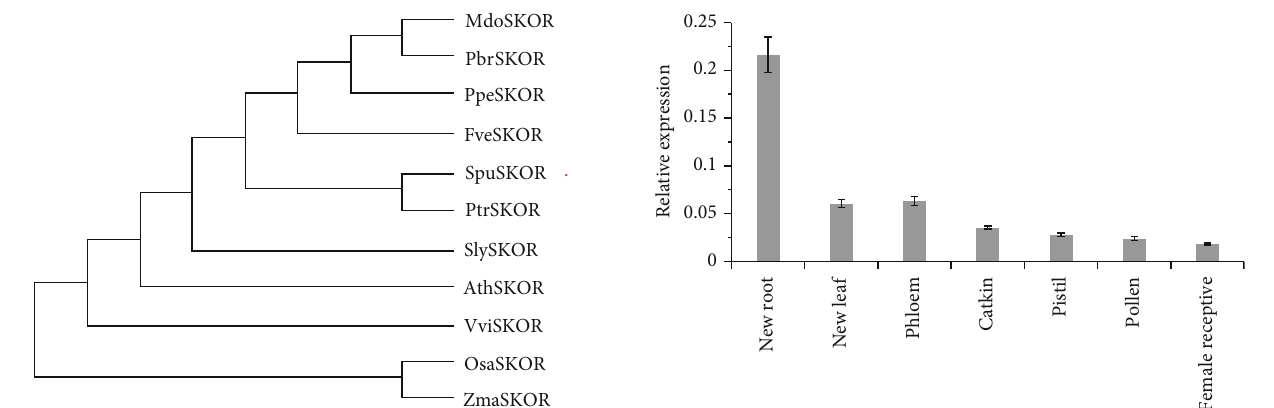
Figure 2: Phylogenetic tree of SKOR proteins from di ff erent plants. A maximum likelihood (ML) tree was constructed by multiple alignment of SKOR proteins in purple osier, Arabidopsis , rice, maize, soybean, tomato, grape, peach, apple, and poplar using the ClustalX2.1 and MEGA7.0 software. Information of SKOR proteins from sequenced plant was listed in Supplemental Table 1. The SpuSKOR protein was labeled with red dot.